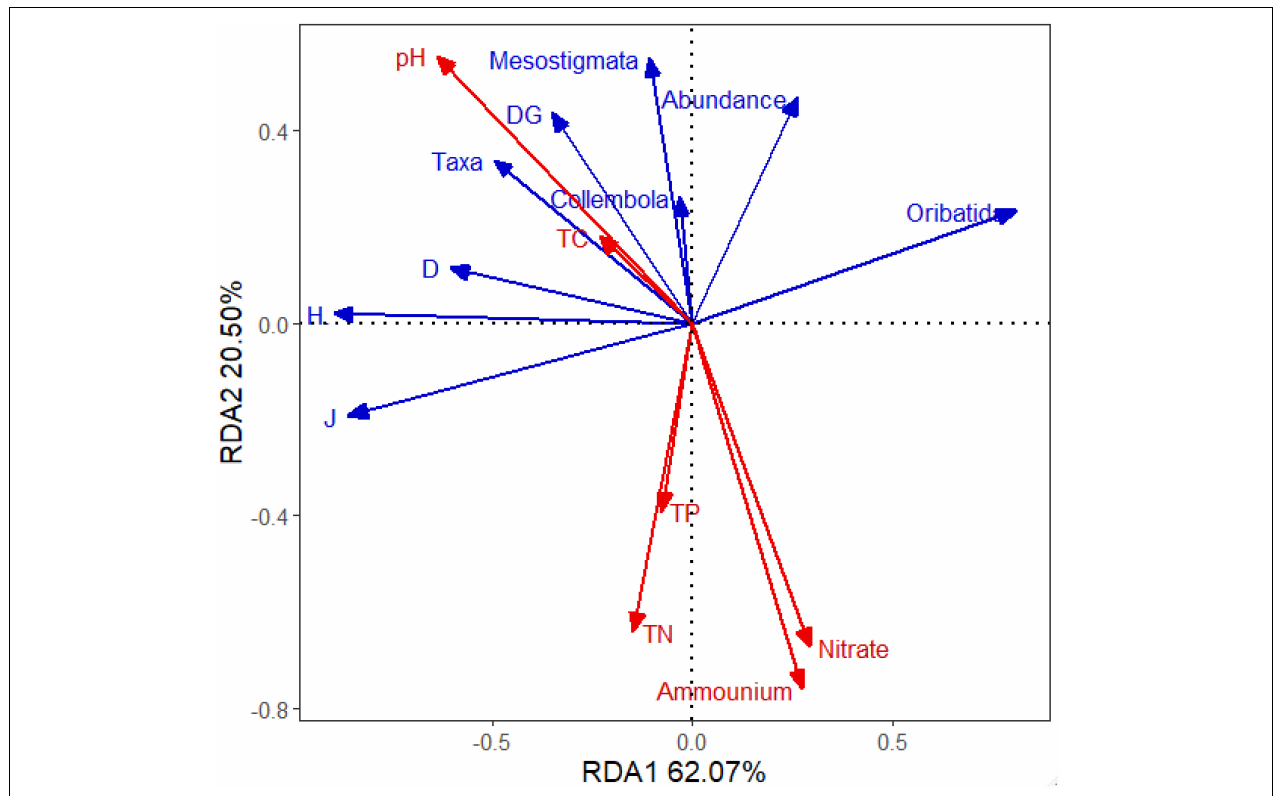
FIGURE 4 | Results of redundancy analysis of main taxa and indices of soil fauna in association with soil chemical properties. Soil fauna data are labeled as: Abundance (community abundance); Taxa (Taxa richness); Oribatida individuals; Collembola individuals; Mesostigmata individuals; DG (Density-Group index); H (cid:48) (Shannon–Wiener index); J (Pielou index); D (Margalef index). Soil chemical properties are labeled as: Ammonium (ammonium nitrogen); Nitrate (nitrate nitrogen); TN (total nitrogen); TC (total carbon); TP (total